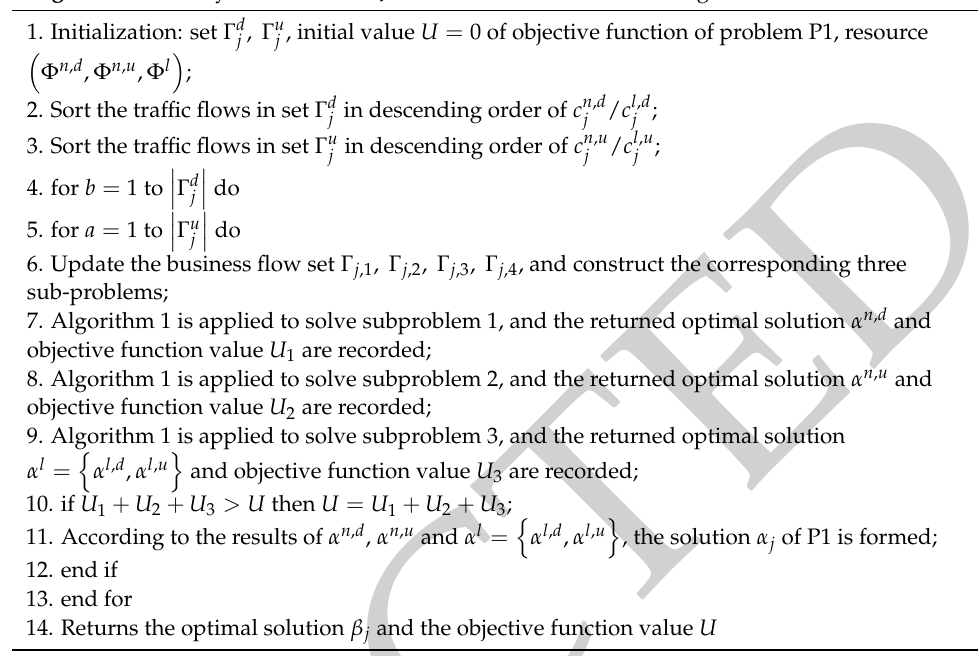
Algorithm 2. Utility of base station J based on resource allocation algorithm.